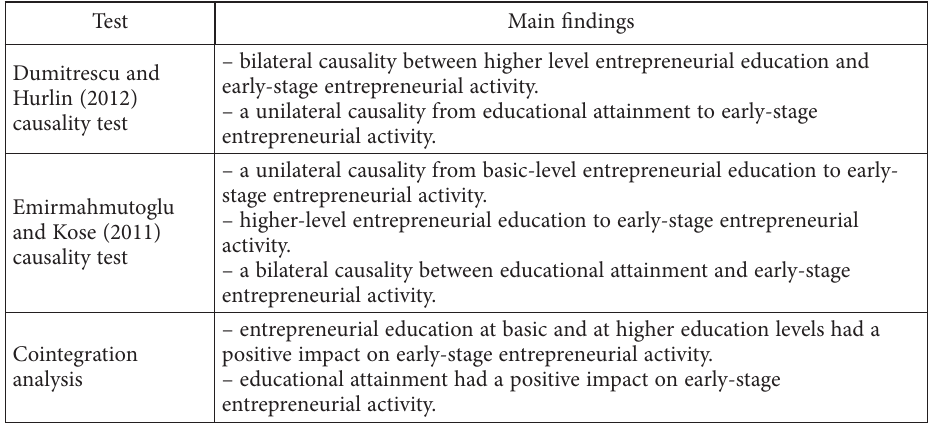
Table 11. Summary of empirical